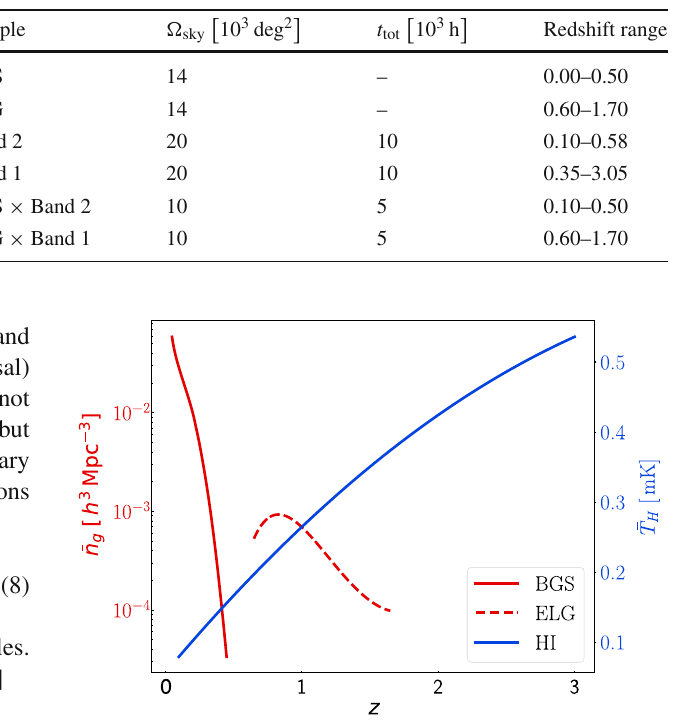
Fig. 1 Background comoving galaxy number densities (red, left-hand y -axis) and HI IM temperature (blue, right-hand y